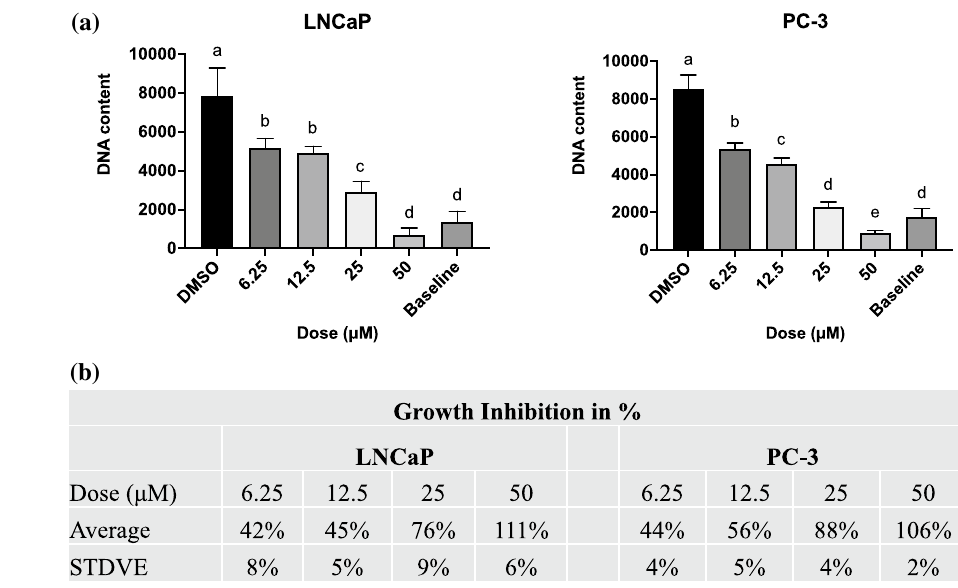
Fig. 1 Apigenin inhibited the DNA synthesis in prostate cancer cells. a LNCaP and PC-3 cells were treated with apigenin at indicated doses for 72 h and harvested for SYBR Green assay. DNA con- tents were expressed as the mean ± SD of three independ- ent experiments. Means with- out a common letter differ, p < 0.05. b The percentage of growth inhibition by apigenin in two prostate cancer cell lines were calculated and showed as mean ±